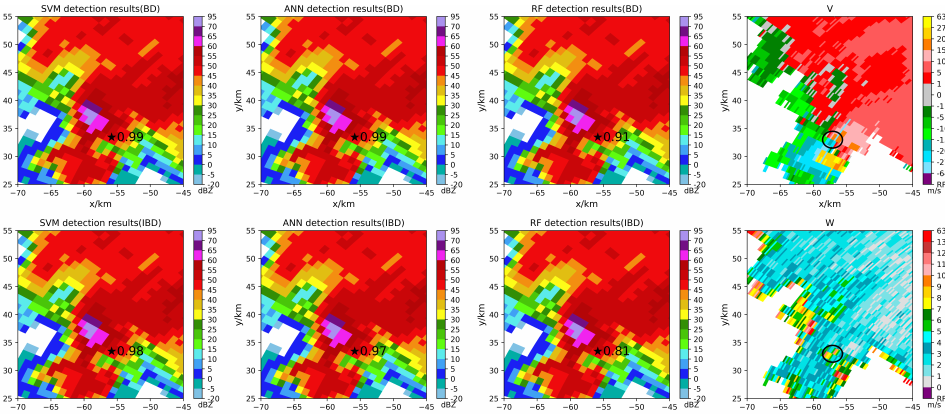
Figure 6. The results of models early warning the tornado at 14:14 (Beijing time, UTC+8) 1.5-degree (the black circle centered at the models warning results with a radius of 1.5 km, the SVM, ANN, RF represent Support Vector Classifier, Artificial Neural Network Classifier, Random Forest Classifier, the V represents Doppler Velocity, and the W represents Doppler Velocity Spectral Width. The BD indicates that the classifier was formed on a balanced tornado dataset, and the IBD indicates that the classifier was formed on an imbalanced tornado